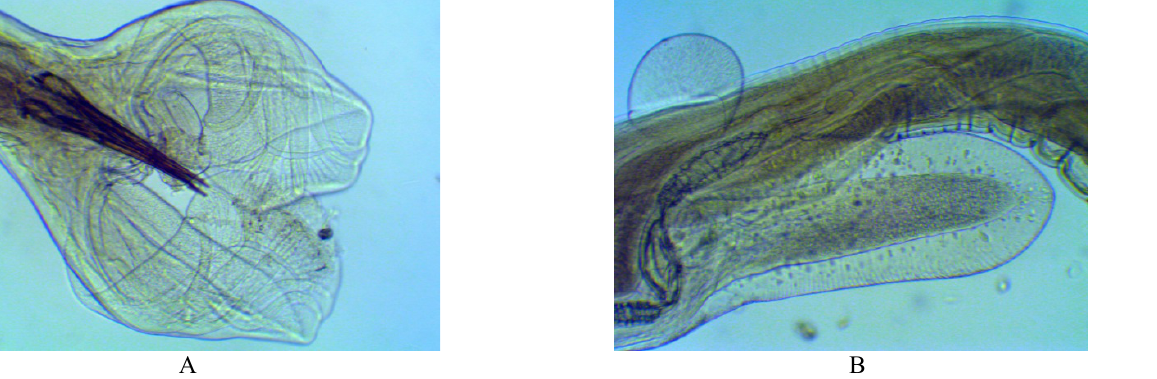
Fig. 3 . H. contortus (× 100): А – Tail end ♂; B – Vulva